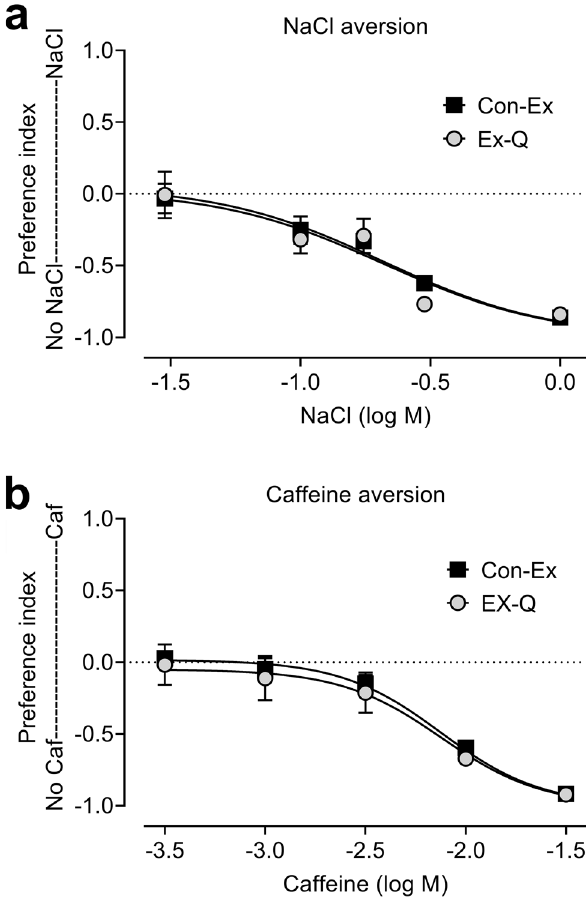
Figure 7. Con-Ex and EX-Q in food preference: preference index. Preference indexes determined from the data in Supplementary Figs. 7 and 8. Con-Ex and EX-Q both detected aversion to NaCl ( a ) and caffeine ( b ) and there were no differences in slopes or IC 50 values due to the method used ( a , NaCl, p = 0.4458, common IC50 value = 208 mM; b , caffeine, p = 0.6899, common IC50 value = 7.5 mM; n =